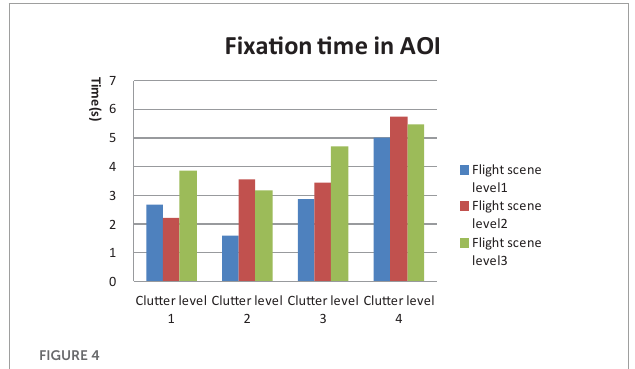
FIGURE4 General linear model (GLM) Univariate test of fixation time in areas of interest (AOI).